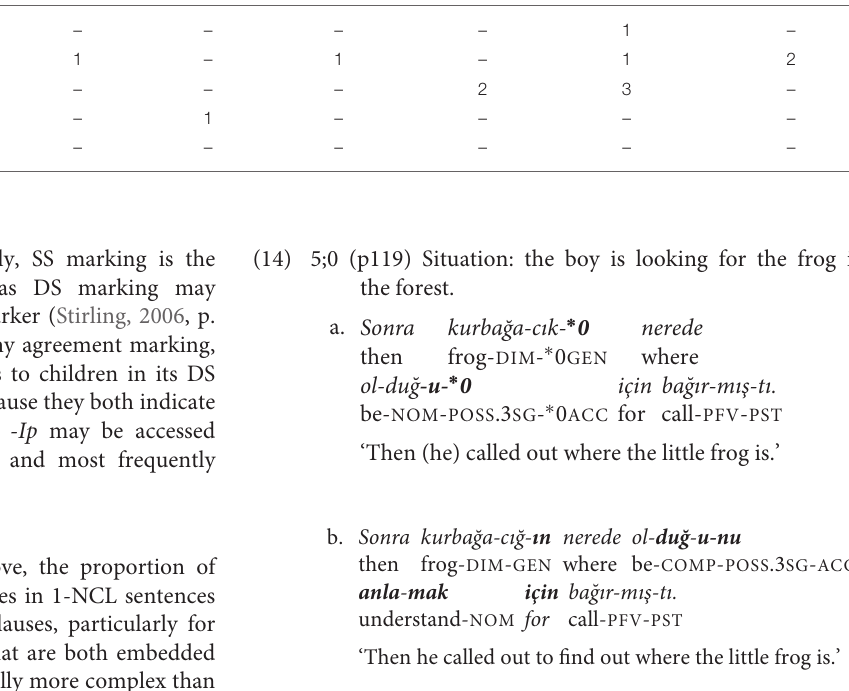
TABLE 6 | Distribution of types of errors by age. Syntactic error Semantic error Wrong chaining device Missing genitive Missing